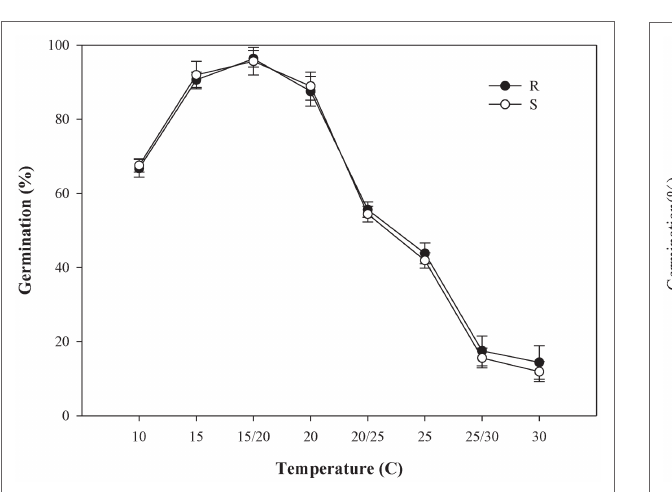
FIGURE 5 | Effect of pH on the germination of the different Polypogon fugax populations. Error bars represent standard error of the means. Values represent the mean of eight replications with 40 seeds per replication. The abbreviations R and S represent for the resistant and sensitive P. fugax populations, respectively.